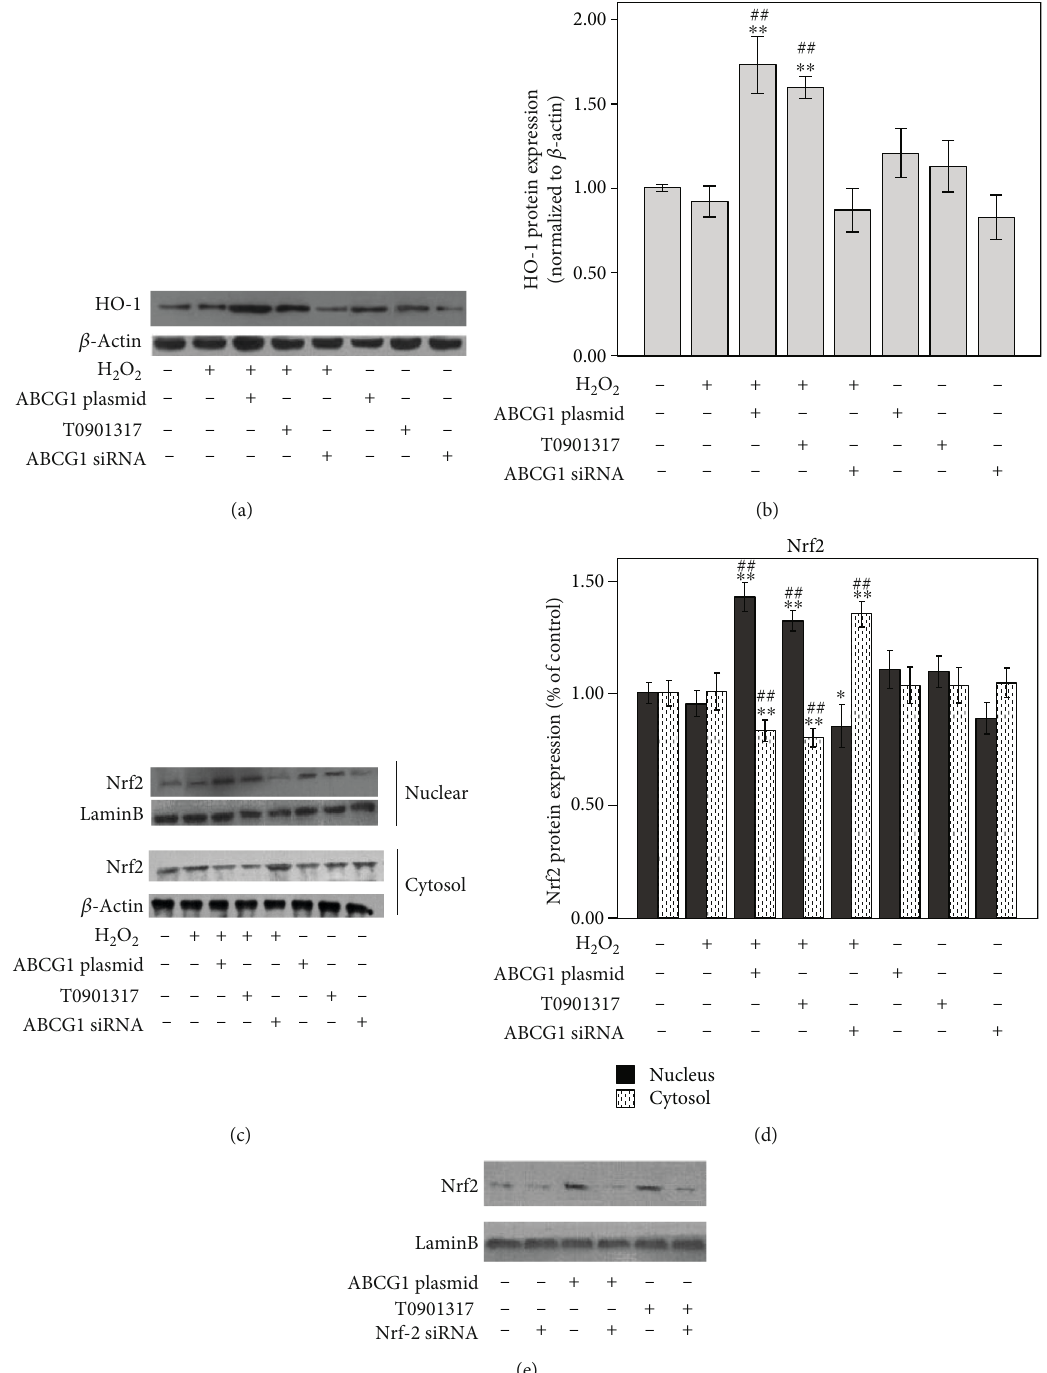
Figure 4: E ff ect of ABCG1 on antioxidative Nrf2/HO-1 signals in HUAECs treated with H ABCG1 siRNA or ABCG1 overexpression plasmid or preincubated with T0901317 and then treated with H 1 protein expression and (c, d) Nrf2 expression in both the cytoplasm and nucleus were measured by western blotting. (e) Nrf2 expression was inhibited by Nrf2 siRNA under the condition of ABCG1 overexpression. Data shown are means ± SD ( n = 3 ). ∗ P < 0 : 05 , ∗∗ P < 0 : 001 vs. controls; ## P < 0 : 001 vs. HUAECs incubated with H